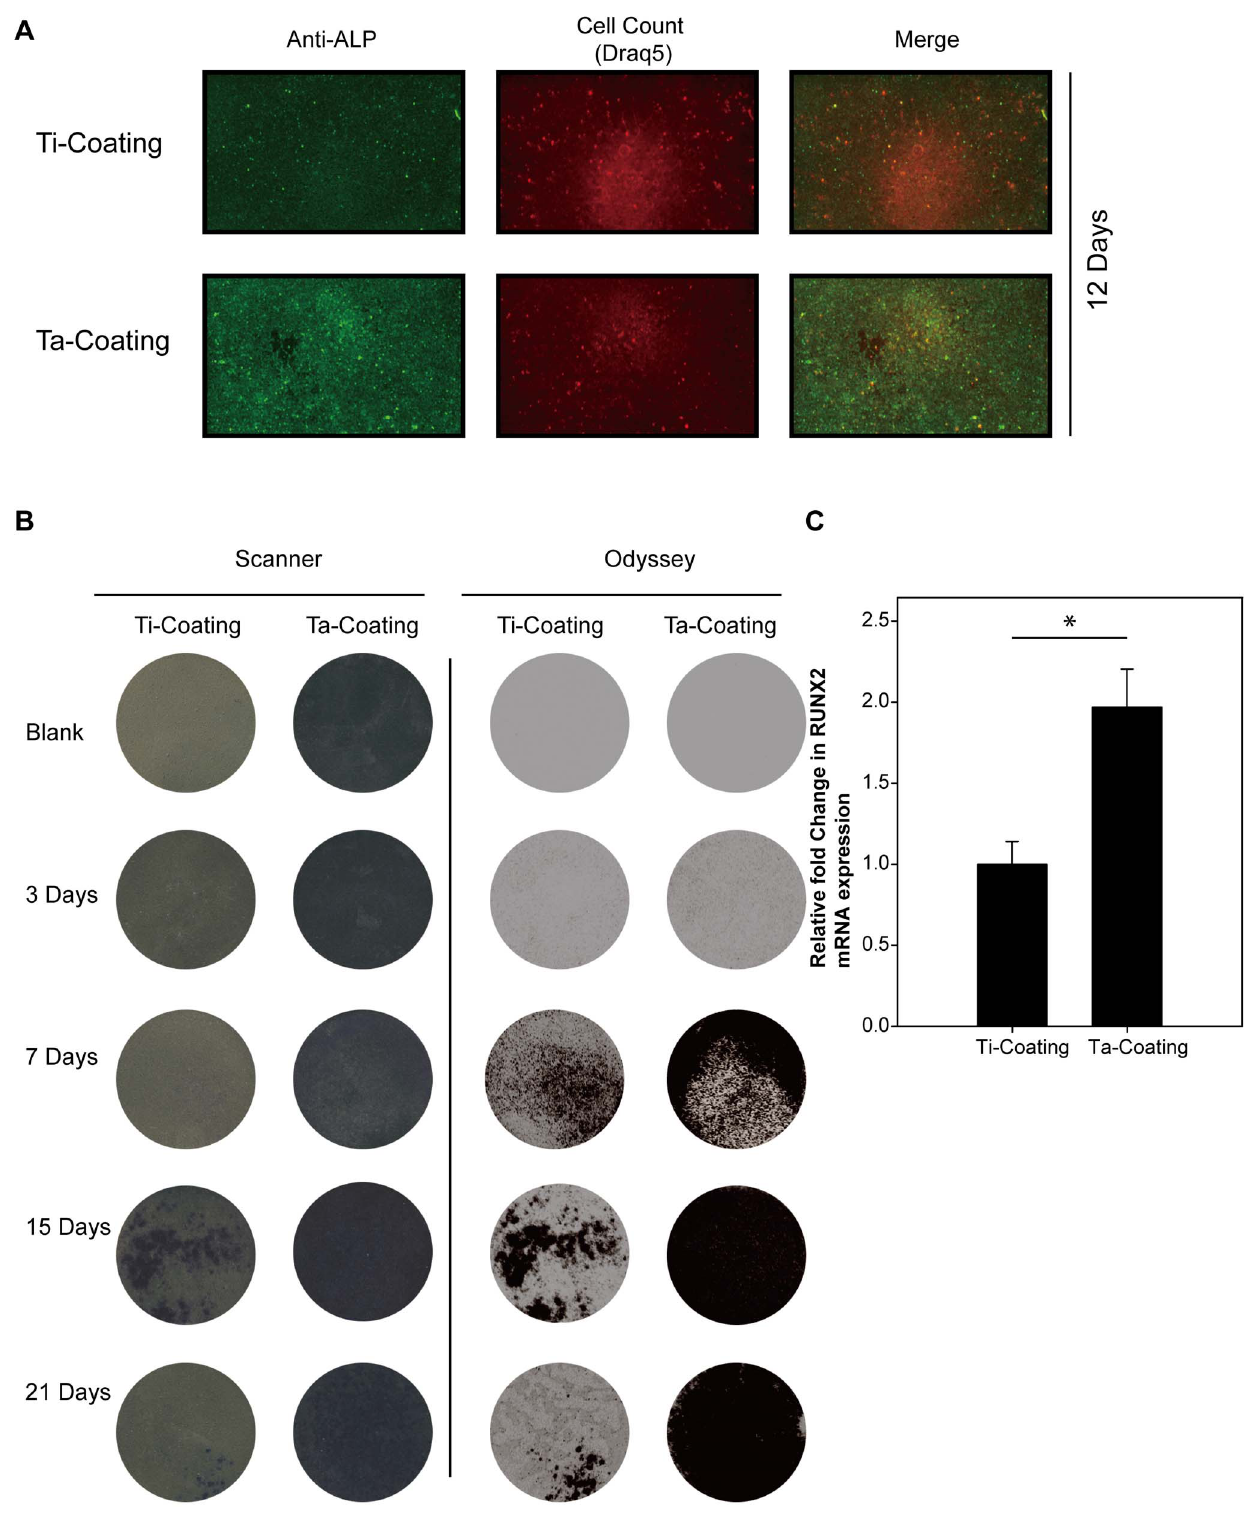
Figure 5. ALP and RUNX2 expression of hBMSCs on Ta and Ti coatings with osteogenic induction. ( A ) Odyssey scanning of the ALP protein expression in hBMSCs on the coatings with DRAQ5 as reference, 12 days. ( B ) ALP activity stain assay of hBMSCs on the coatings in 3, 7, 15, and 21 days with a white light scanner and near-infrared Odyssey scanner. ( C ) Real-time PCR detection of the mRNA expression of RUNX2 gene in hBMSCs on the coatings with osteogenic induction for 21 days. GAPDH was used as reference gene (t-test, assuming unequal variances, n =3; Ti coating, 1 6 0.1404; Ta coating, 1.9678 6 0.2370; Prob . |t|, , 0.01*).